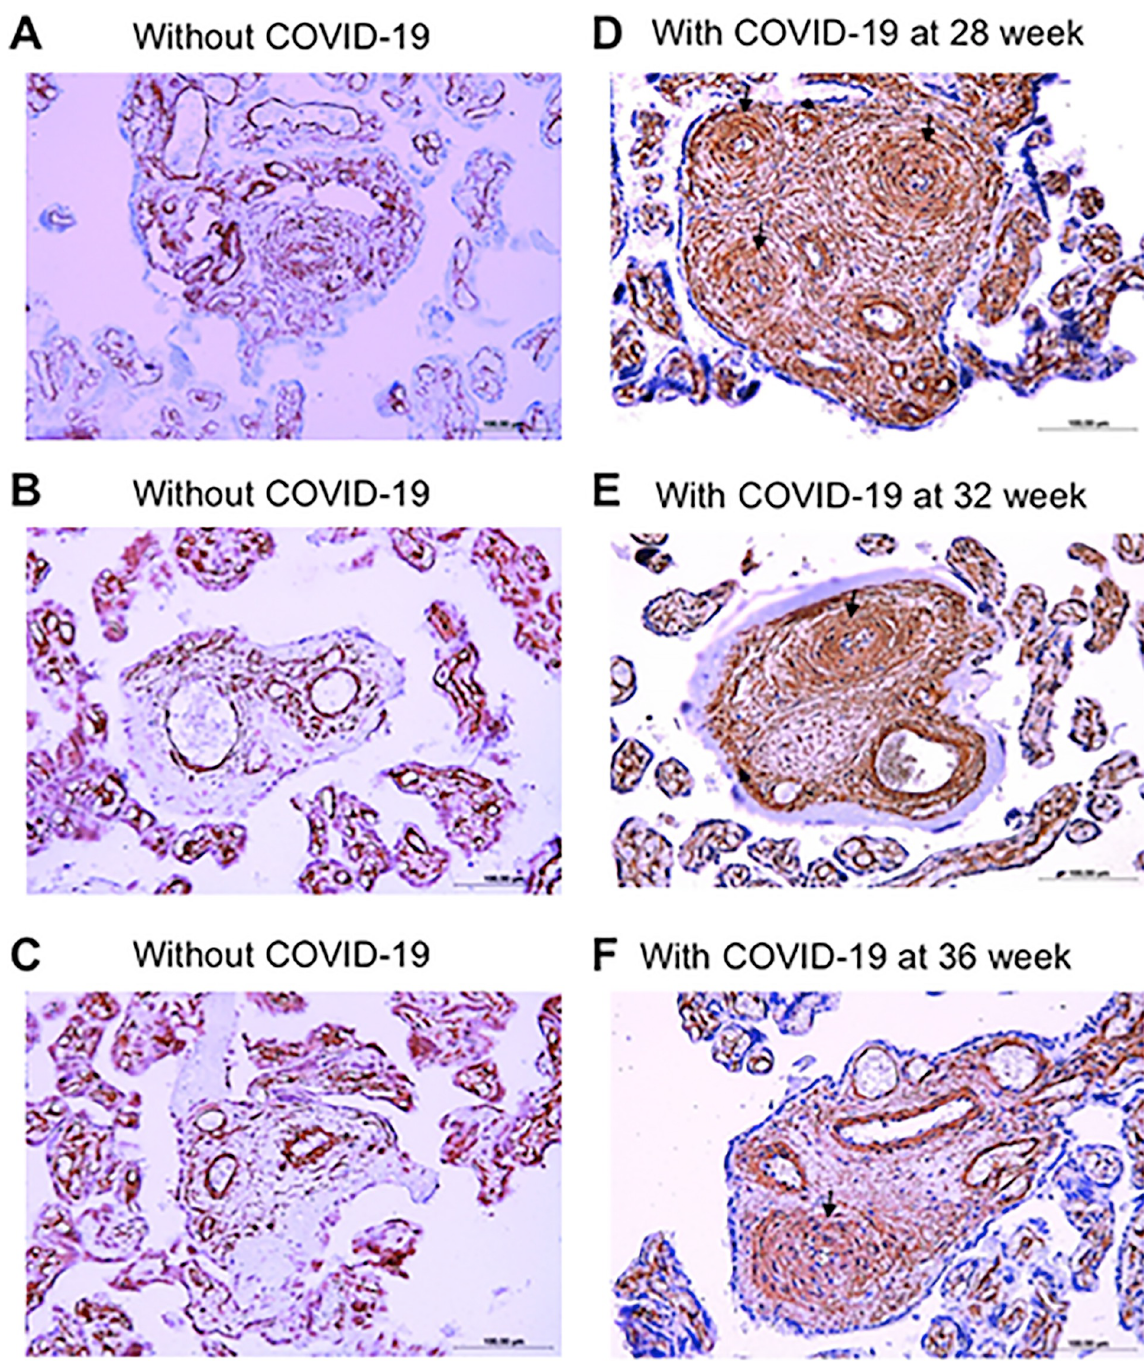
Fig 4. Immunohistochemistry of α -smooth muscle actin in the placental arteries of women who gave birth without or with COVID-19 during pregnancy. (A-C) Immunohistochemistry images of three women who gave birth without contracting COVID-19 (40 weeks of gestation). (D-F) Immunohistochemistry images of three women who gave birth (at 40 weeks of gestation) but contracted COVID-19 at 28, 32, or 36 weeks of gestation. Magnification x200. Arrows indicate remodeled vessels.